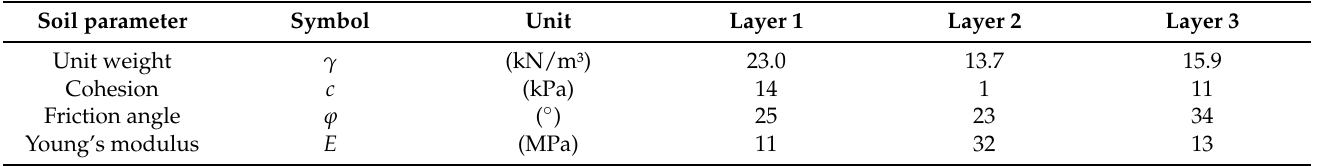
Figure 12. Detail of the linearly increasing support pressure at the tunnel face and the resulting horizontal displacement at a randomly selected excavation step. Table 5. Soil property values assigned to the soil layers 1 (yellow), 2 (green), and 3 (orange) of Figure